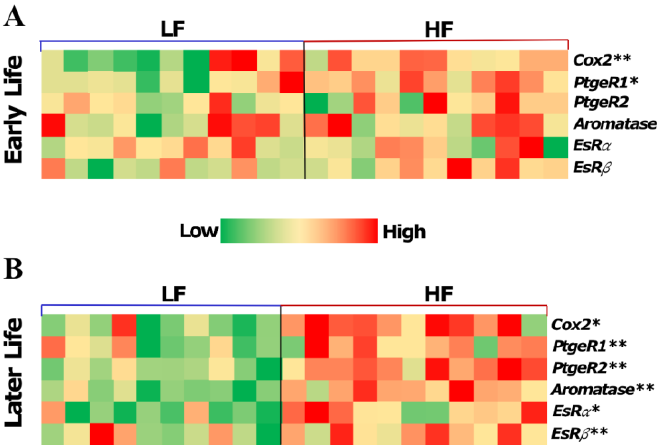
Figure 3. Effect of high-fat diet in early life on the expressions of hormone-related genes in the inguinal mammary tissues from mice sacrificed in early life immediately after the 8 week experimental HF/LF diet feeding at the age of ~12 weeks ( A ) and in later life after switching to the normal diet for an additional 12 weeks and at the age of ~24 weeks ( B ). Data are presented as mean ± SEM. n = 8–11 animals/group. *: p < 0.05; **: p < 0.01.